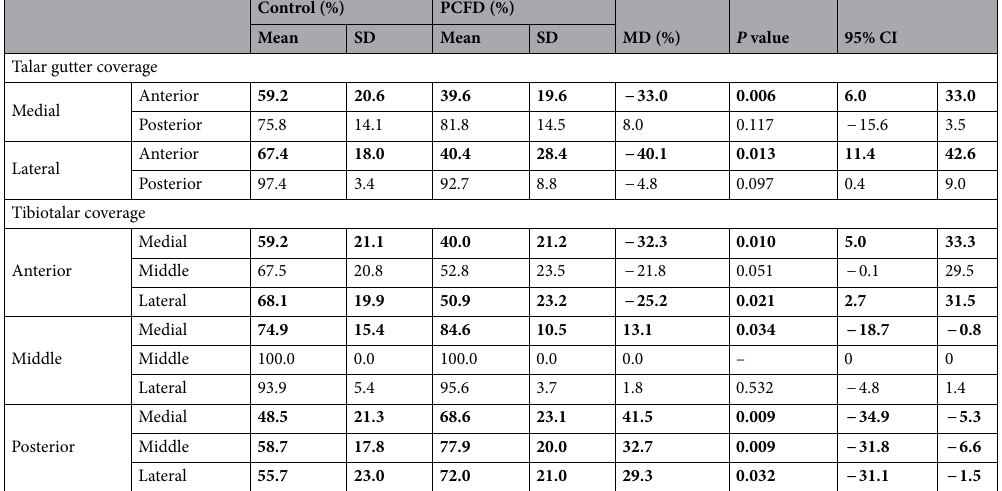
Table 5. Means and Standard Deviations for Tibiotalar and Talofibular Coverage Measured as a Percentage of Total Area Covered in Each Region, and Mean Difference in Coverage from Control to Progressive Collapsing Foot Deformity Patients with P Values and 95% Confidence Intervals for Comparisons. Bolded rows denote significant changes within the region. PCFD progressive collapsing foot deformity, MD mean difference, SD standard deviation, CI confidence interval. *Statistically significant ( p <